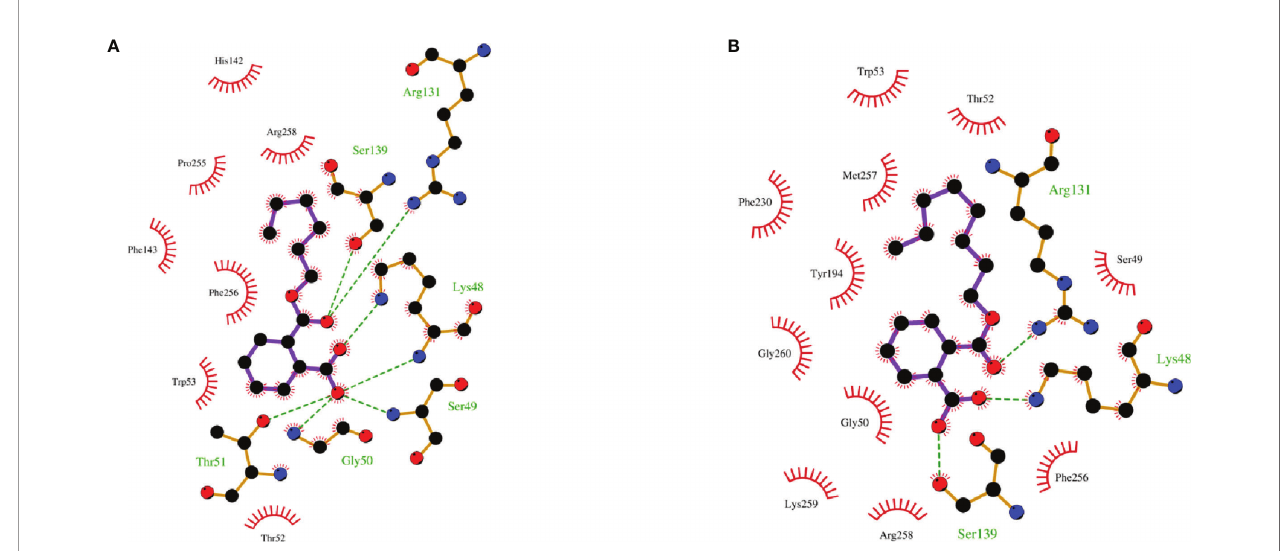
FIGURE 7 | Hydrophobic interaction between MHP (A) and MOP (B) and the active cavity of